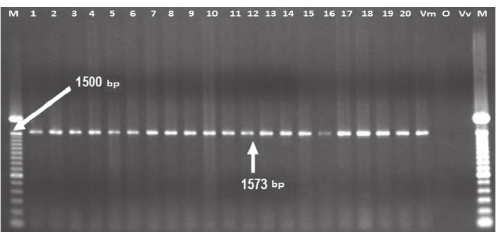
Figure 3: Electrophoresis gel of iuT gene amplification product. Lanes (M): 100bp molecular weight marker; lanes 1–20: isolated strains of V. mimicus ; lane (Vm): V. mimicus ATCC 33653; lane (O) V. cholerae O1 Ogawa; lane (Vv): V. vulnificus ATCC 29307.